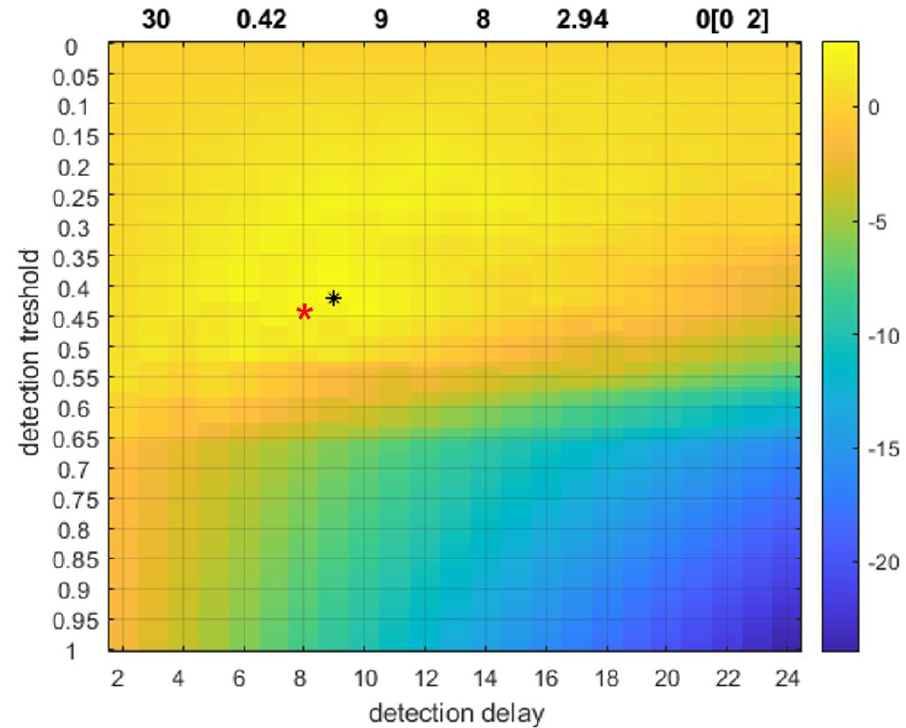
Figure 6. Stability of the adaptive approach. The notations are the same as on Figure 4, panel (b).